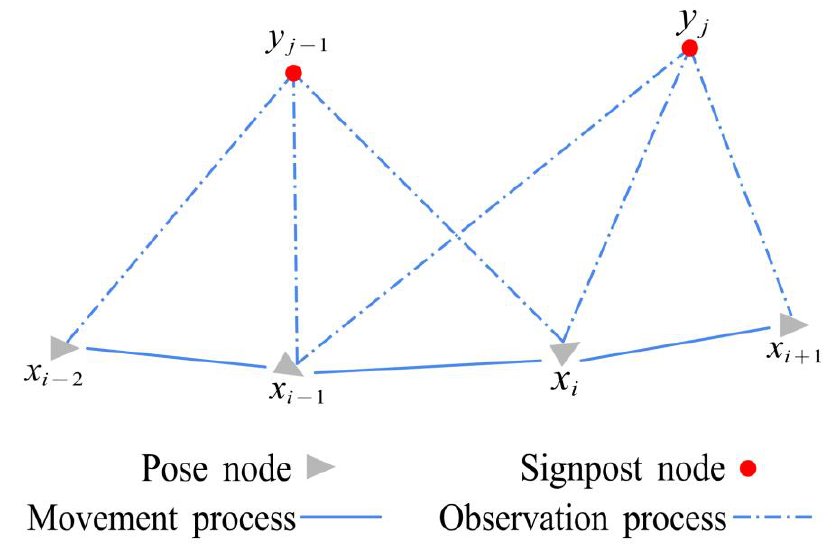
Figure 3. SLAM motion model of the roadheader.